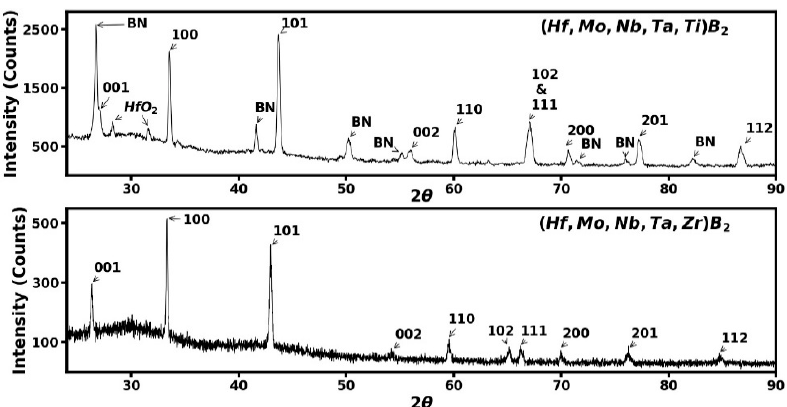
Figure 4. The angle-dispersive X-ray diffraction spectra for the two samples at ambient conditions after synthesis at high pressures and high temperatures. Both samples show a single hexagonal AlB 2 phase with ten diffraction peaks labeled with ( hkl ) values; no contaminants were detected. The peaks marked BN come from the sample container used in the synthesis process and very weak unreacted hafnium oxide in the upper panel.